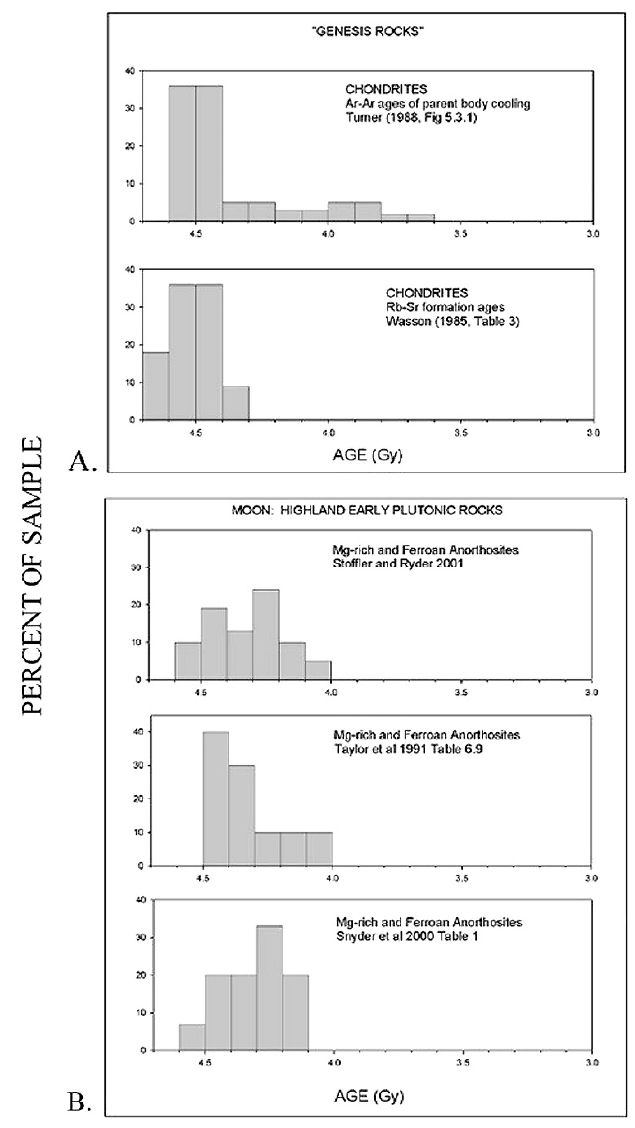
Figure 4. Age distribution of primordial rocks, comparing ( A ) chondrite ages with ( B ) lunar highlands crustal anorthosite rocks. Lunar crustal samples survive from the entire period of at least 4.5 to 4.0 Ga ago, with fewer younger than 4.2 Ga.